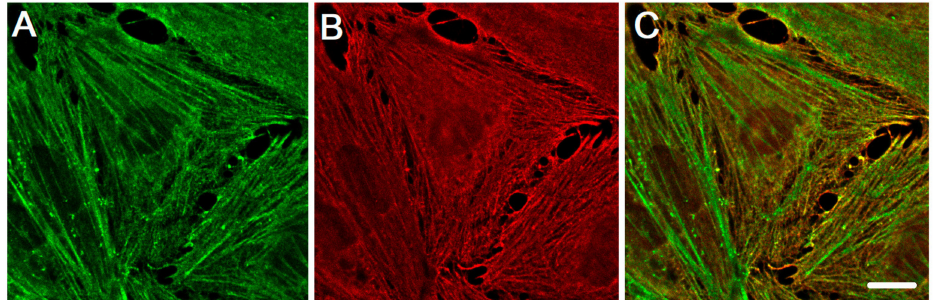
Figure 2. The distribution of cytoplasmic actin isoforms in the cytoplasm of endothelia cell in vitro. β -actin and γ -actin are spatially segregated in human pulmonary aorta endothelial cells. ( A ) β -actin (green), ( B ) γ -actin (red), and a merge of β -actin (green) and γ -actin (red) images ( C ). Structured Illumination Microscopy (SIM). Scale bars: 5 µ m.